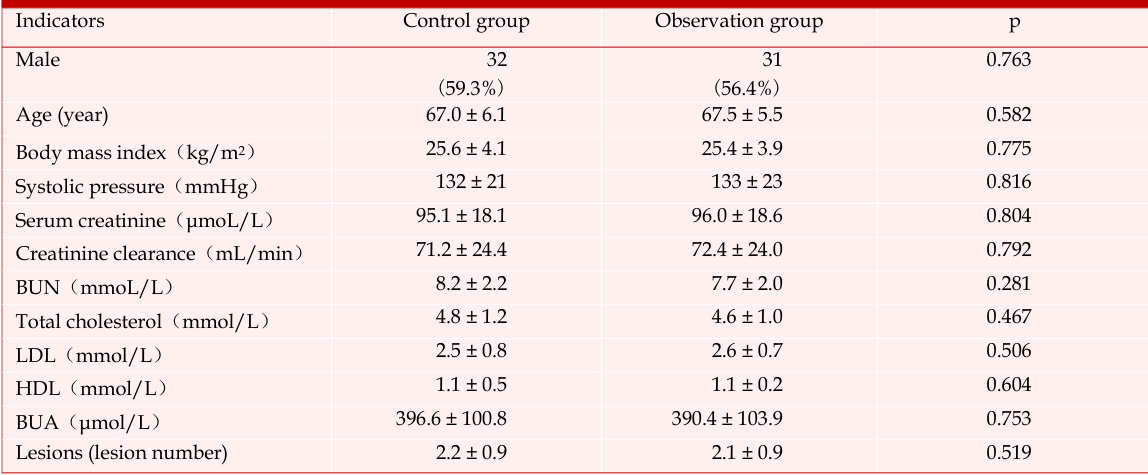
Comparison of preoperative general clinical data and biochemical indicators (` x ± s